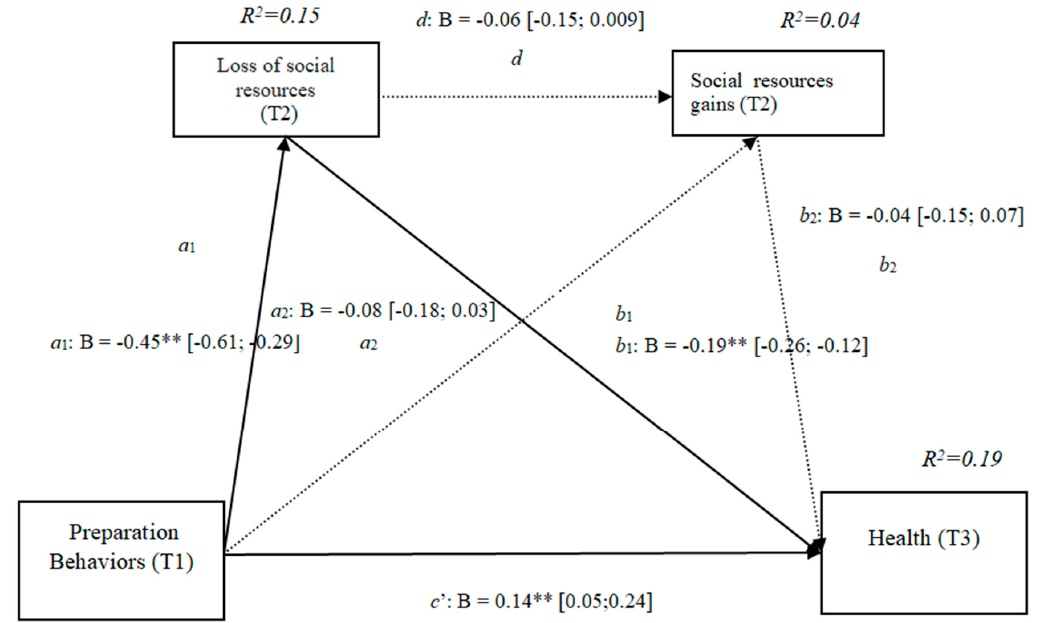
Figure 12. Non-standardized B coefficients, confidence intervals, and statistical significance for social losses and gains. [95% CI]; * p < 0.05; ** p < 0.01.